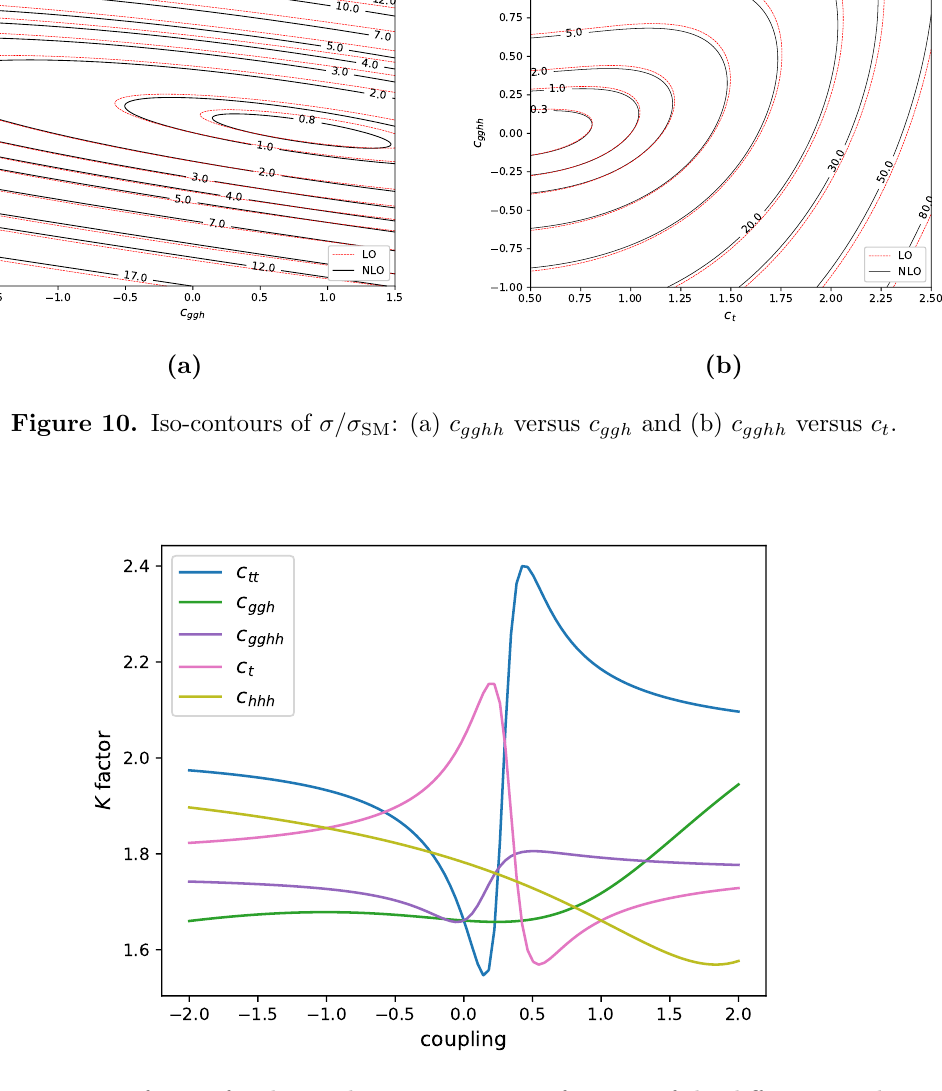
Figure 11. K-factors for the total cross section as a function of the di(cid:11)erent